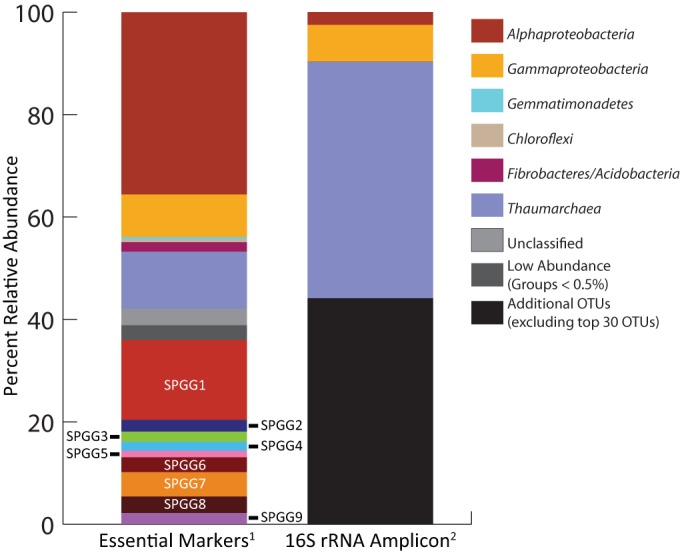
Bar graph representing the various recorded estimates of percent relative abundance of the SPG microbial population. Footnotes: 1, results based on the length-normalized recruitment of metagenomic sequences to conserved marker genes; 2, results taken from Tully and Heidelberg (7), combining the relative abundance of the taxonomic assignments of the 30 most abundant OTUs in the previous study.